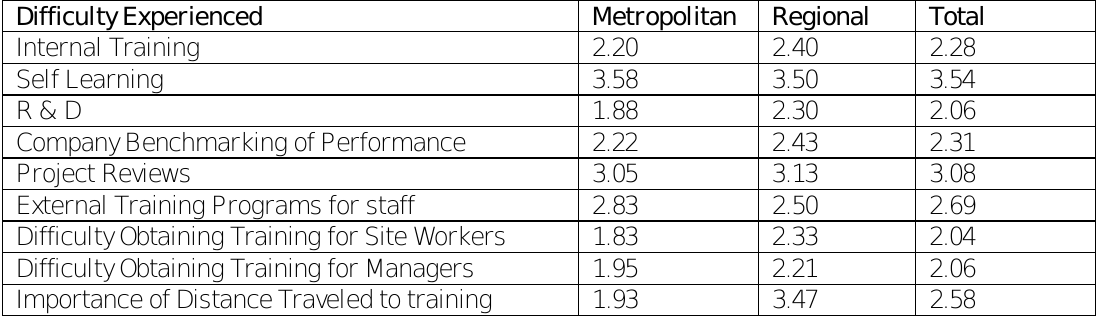
Table 3: Mean Likert values for Labour Difficulties